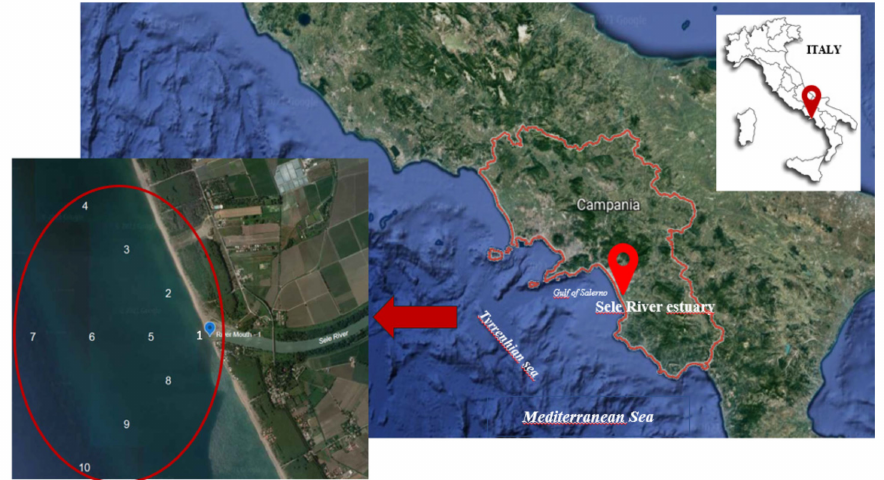
Figure 1. Map of the study area and sampling locations in the Sele River estuary, Southern Italy (Sampling sites: 1—River mouth; 2—Nord estuary at 500 m; 3—Nord estuary at 1000 m; 4—Nord estuary at 1500 m; 5—West estuary at 500 m; 6—West estuary at 1000 m; 7—West estuary at 1500 m; 8—South estuary at 500 m; 9—South estuary at 1000 m; 10—South estuary at 1500